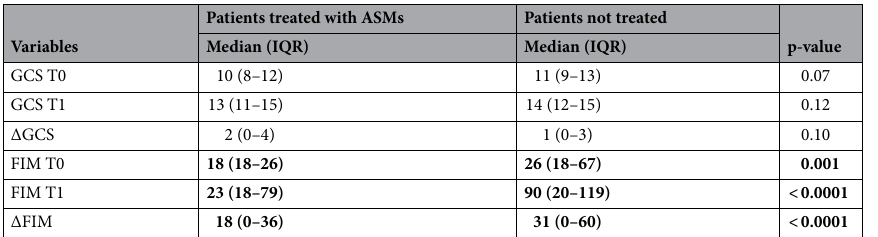
Table 4. Neurological/rehabilitation outcome measured with the Glasgow Coma Scale (GCS) and the Functional Independence Measure (FIM) in patients according to the use or not of ASMs. T0 on admission to neurorehabilitation, T1 at discharge. Data are expressed as median and interquartile range. Comparison between groups was performed using Mann–Whitney test. Significant differences are shown in bold.